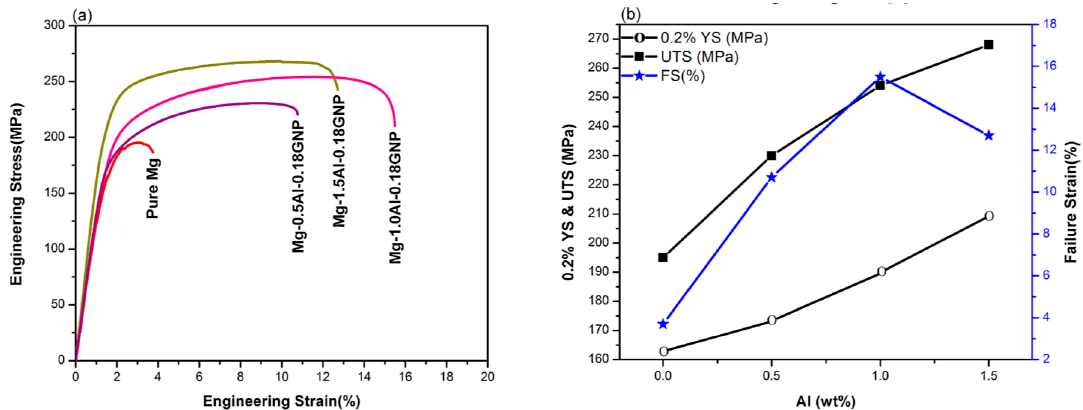
Figure 19. Tensile test of pure Mg and Mg- x Al-0.18GNP composites ( x = 0.5; 1.0; 1.5) [155], Reproduced from [155], with permission from Springer Elsevier, 2015.